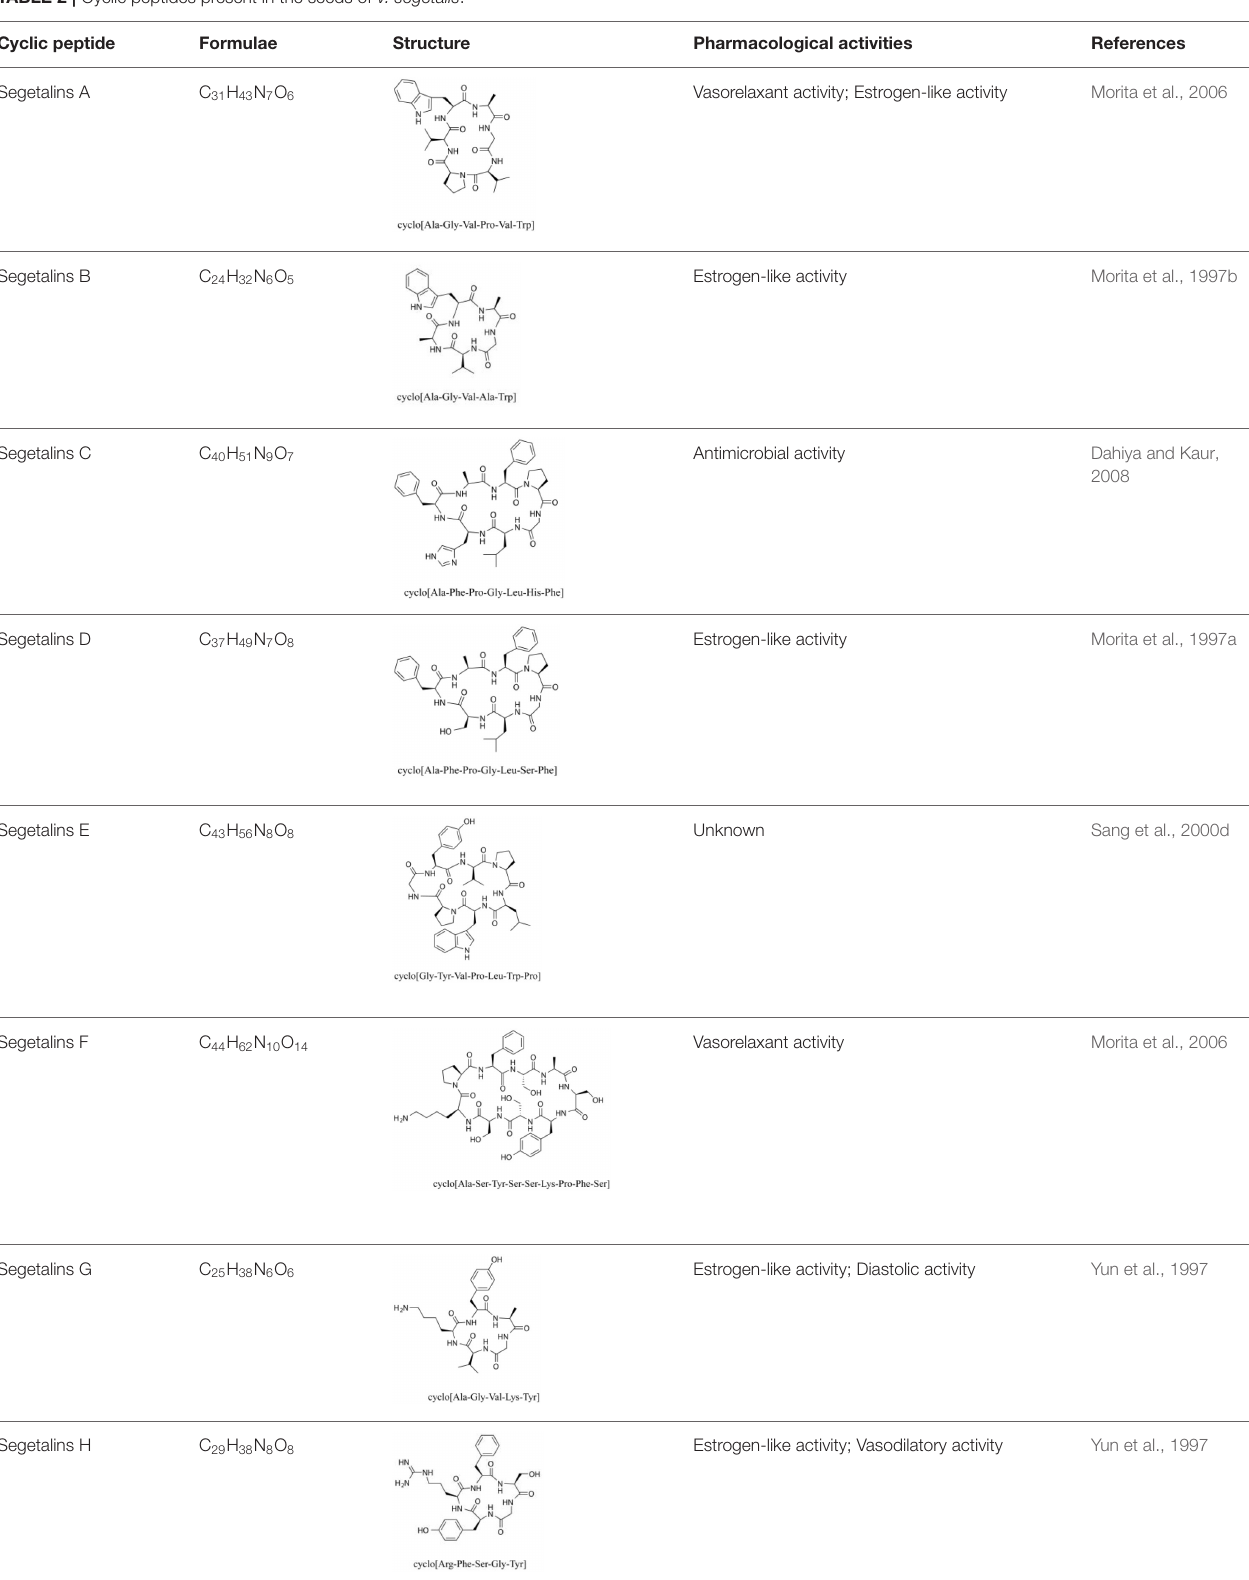
TABLE 2 | Cyclic peptides present in the seeds of V. segetalis . Cyclic